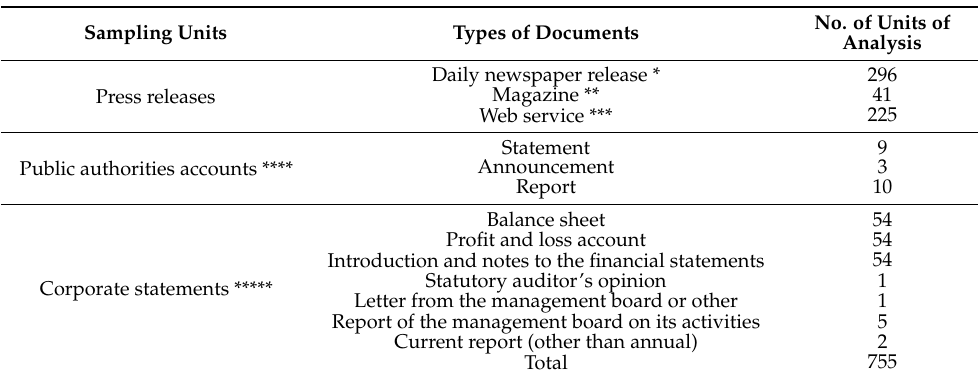
Table 1. Characteristics of the research